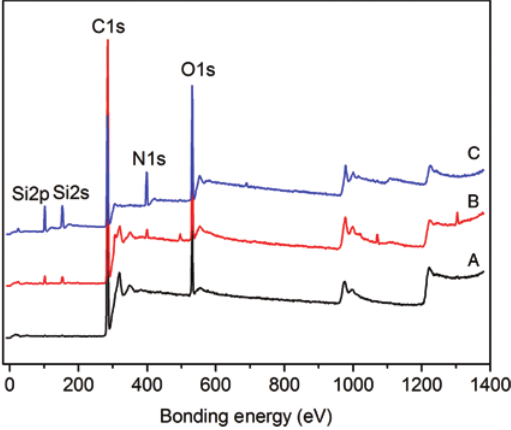
Figure 5: XPS spectra of (A) pristine diamond, (B) KH550 modified diamond in aqueous alcohol, (C) KH550 modified diamond in